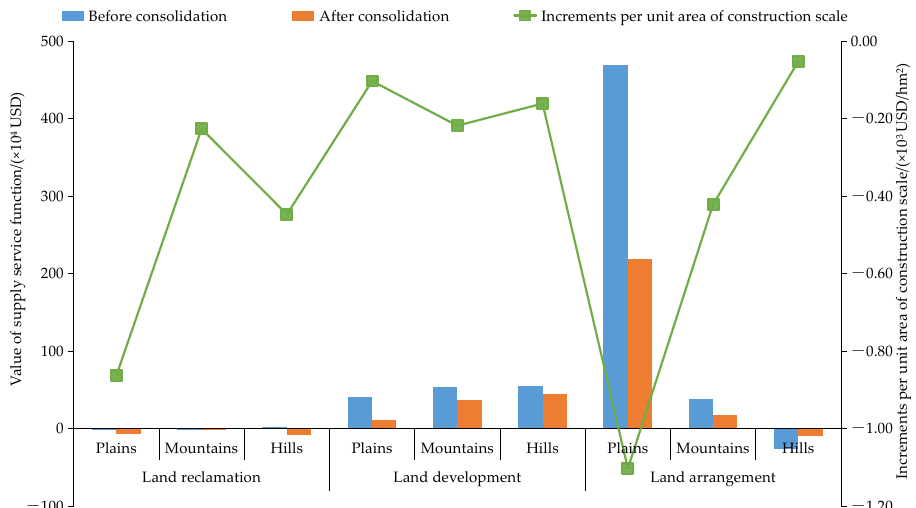
Figure 3. Change in value of supply service function before and after consolidation in typical land consolidation project areas in Hubei province. Note: The value of the supply service function of land consolidation projects with different natures and landforms is the average value of the three typical projects, which is the same as below.